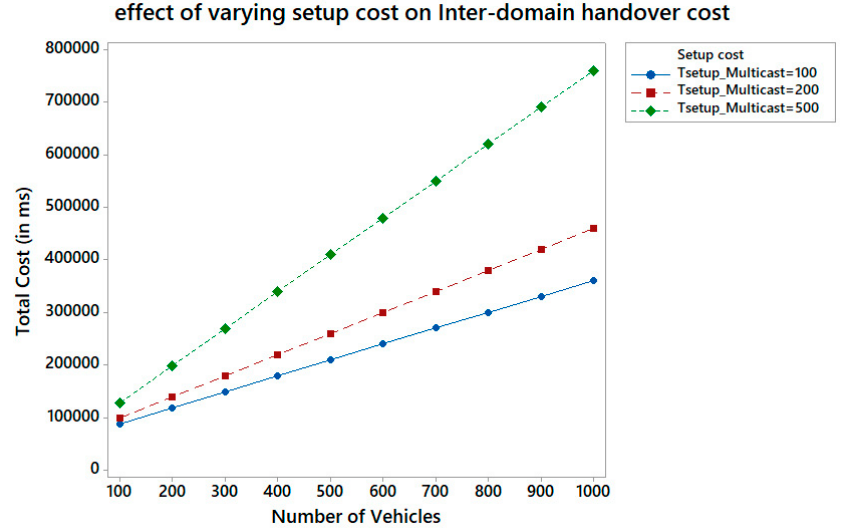
Figure 9. Effect of varying setup cost on inter-domain handoff .